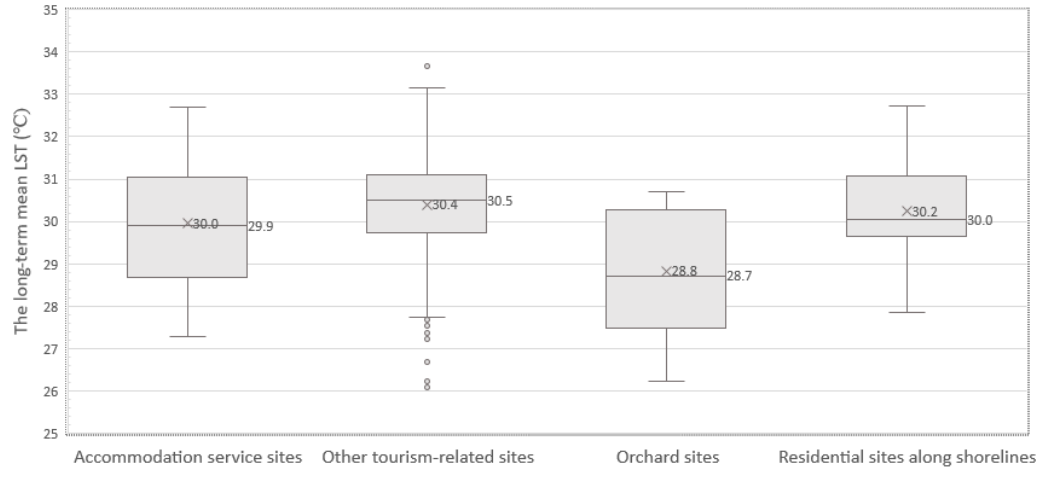
Figure 8. The statistics of the mean LST for the four function-defined tourism-related sites.